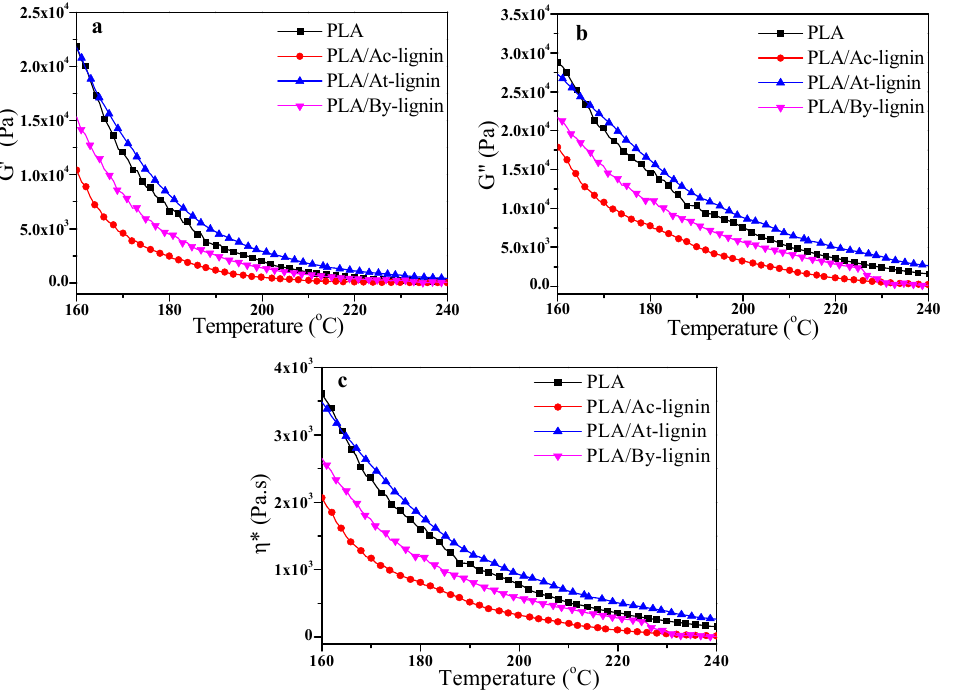
Figure 17. Temperature ramp sweep curves for pure PLA, PLA / Ac-lignin, PLA / At-lignin, and PLA / By-lignin biocomposites: ( a ) Storage modulus ( G (cid:48) ), ( b ) loss modulus ( G” ), ( c ) complex viscosity ( η